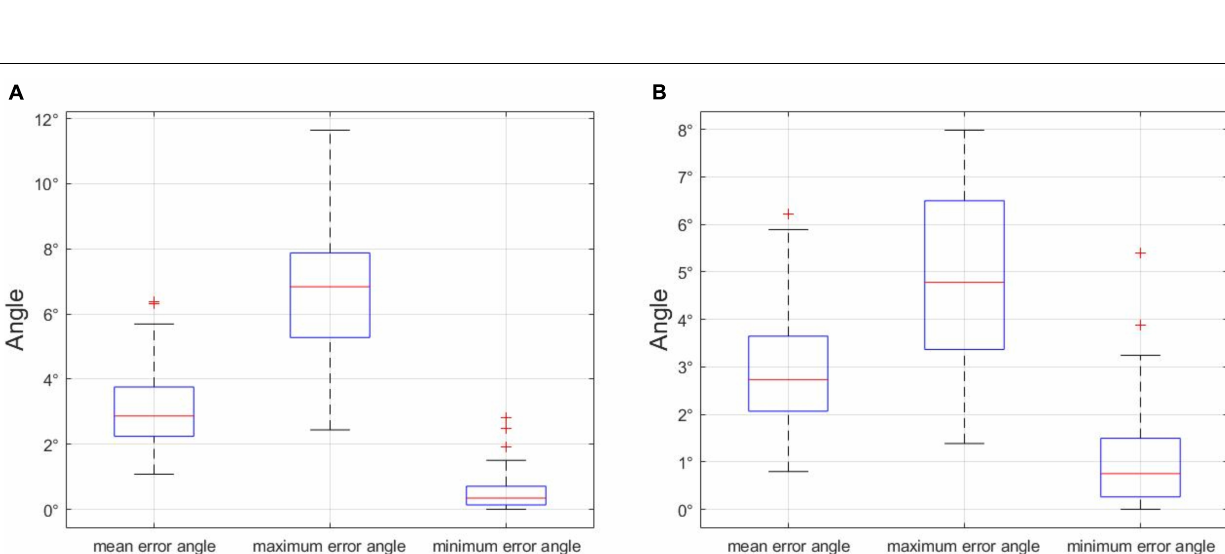
Frontiers in Plant Science |